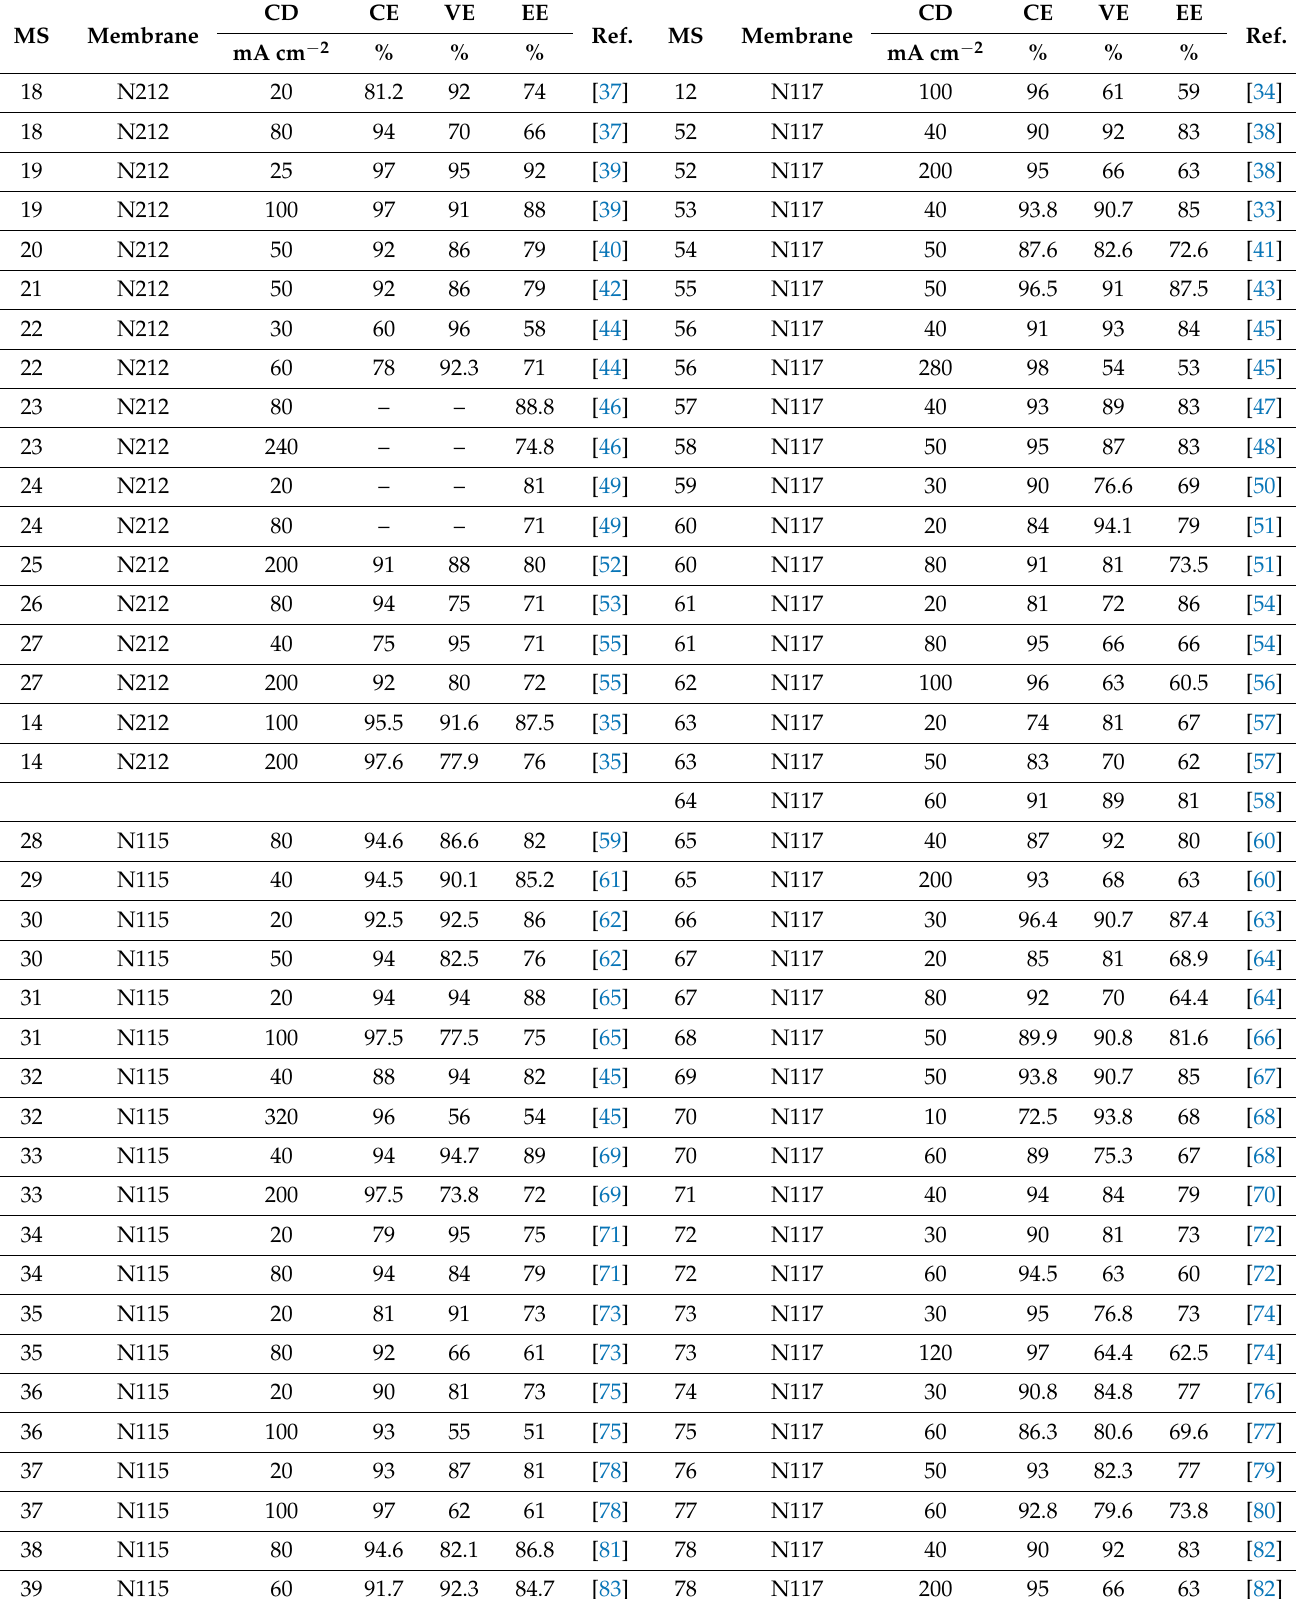
Table 3. The efficiencies of VRFB cells using the listed reference membranes N212, N115 and N117 for investigated current